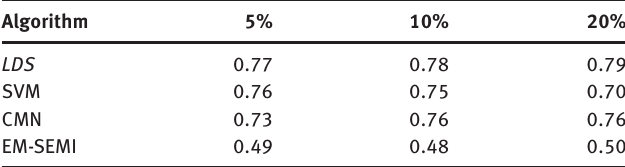
Table 3. Performance Results on KC1.